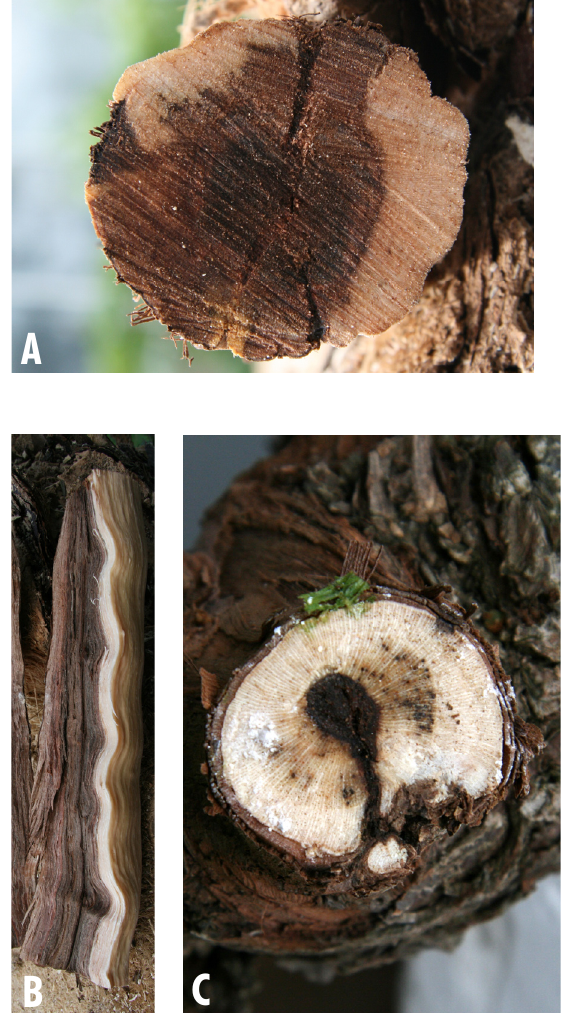
Fig. 3. Mild chlorosis in the marginal and interveinal leaves of cv. Insolia. All vines showing foliar chlorosis sampled were infected with L. theobromae